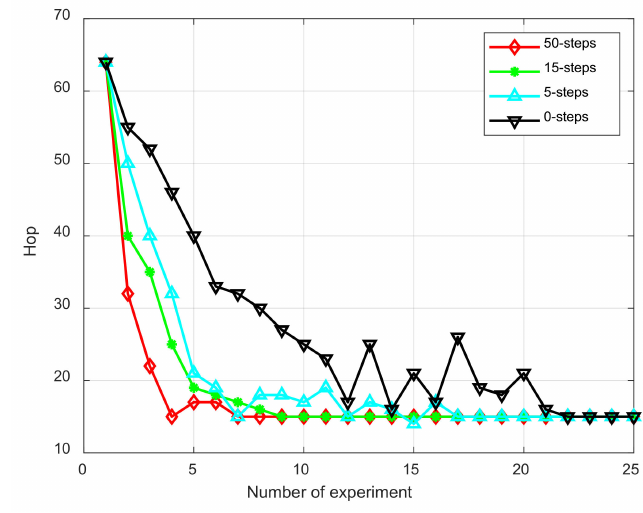
Figure 9. Minimum hops required for each different number of